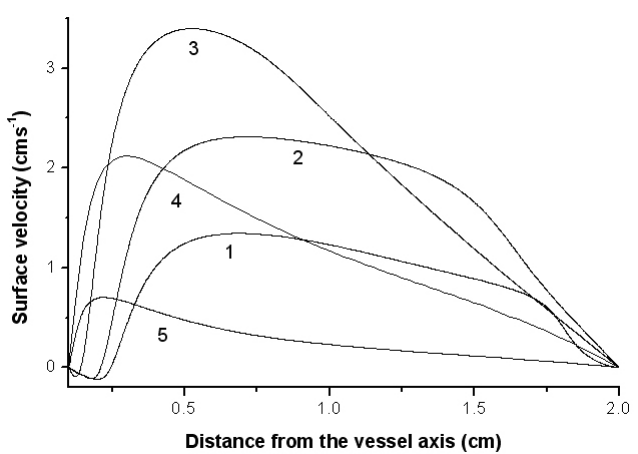
Figure 11. Numerical results on the radial distribution of the surface velocity by dissolution of a hexanol droplet under the air/water surface: 1 – t=26 min 11 s, 2 – t=26 min 12 s, 3 – t=26 min 13 s, 4 – t=26 min 14 s, 5 – t=26 min 20 s (for the oscillatory regime shown in Fig. 8, reprinted from [43], with permission from American Physical Society).